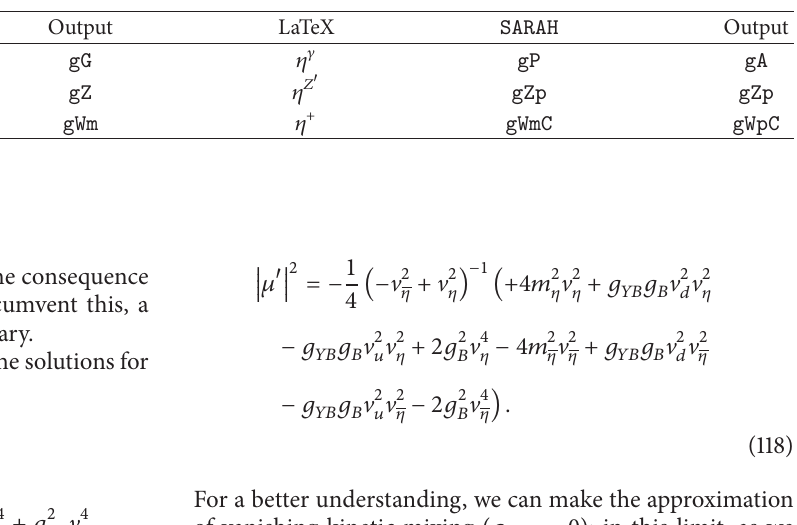
Table 5: Ghost particles in the B-L- SSM after electroweak symmetry